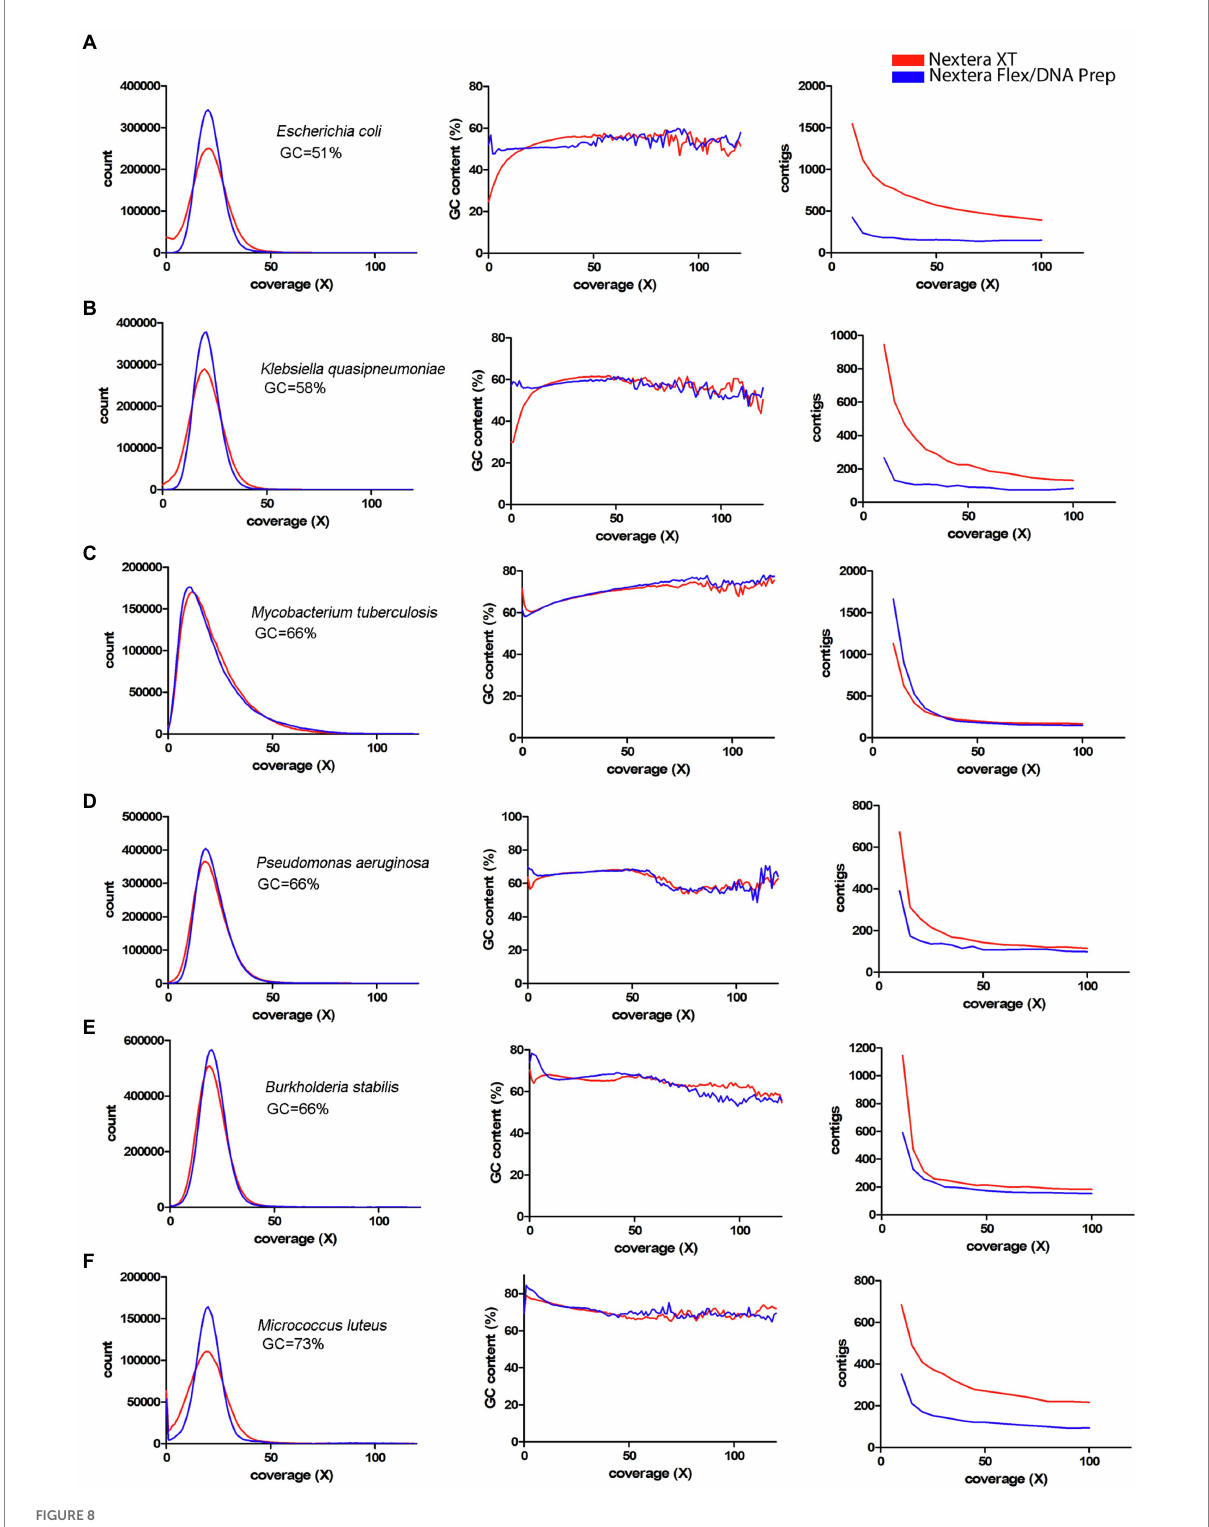
FIGURE 8 Coverage bias, connection to GC-content, and consequences on assembly efficiency for data produced with Nextera XT and Nextera Flex/DNA Prep in external datasets. The data have been colored to indicate the type of library prep kit used (Nextera XT red, Nextera Flex/DNA Prep blue). Left column represents histograms over the depth in the raw data (downsampled to 50x) of the k -mers present in the reference sequence. Middle column represents the corresponding average GC-content of the k -mers in each histogram bin. The right column represents the number of contigs generated by SPAdes assembler after filtering short and low coverage contigs. (A–F) Data from Seth-Smith et al. (2019) representing bacterial species with medium or high